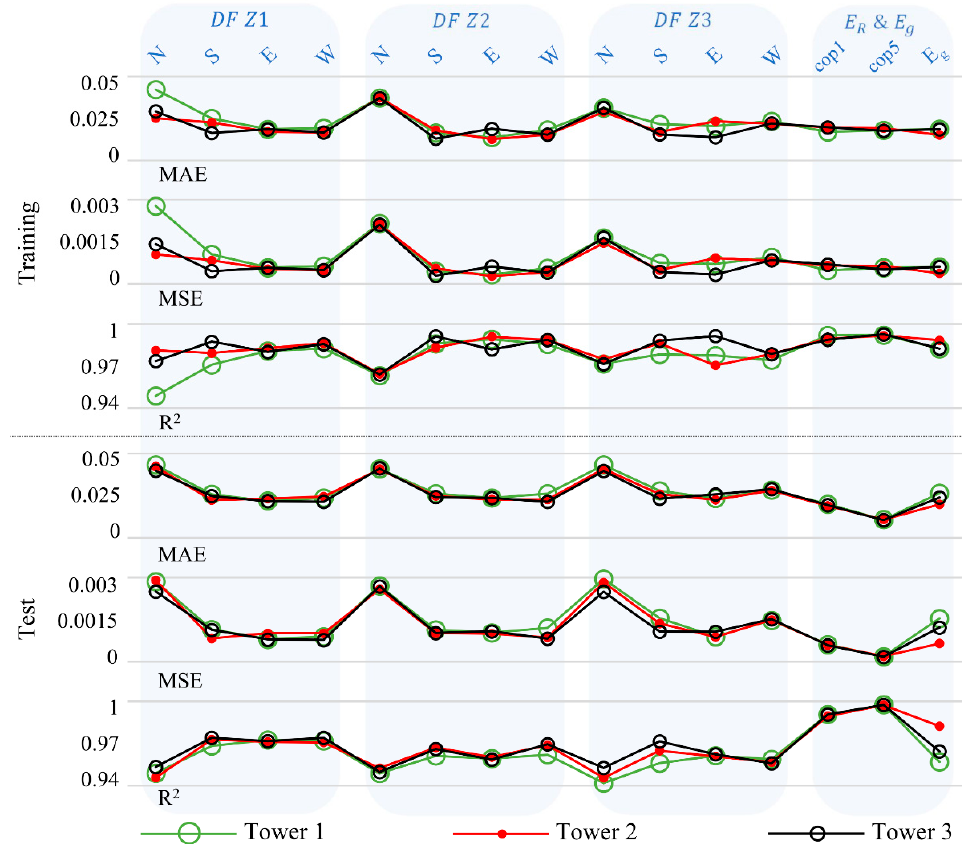
Figure 14. MAE, MSE, and R 2 results of training and test sets.